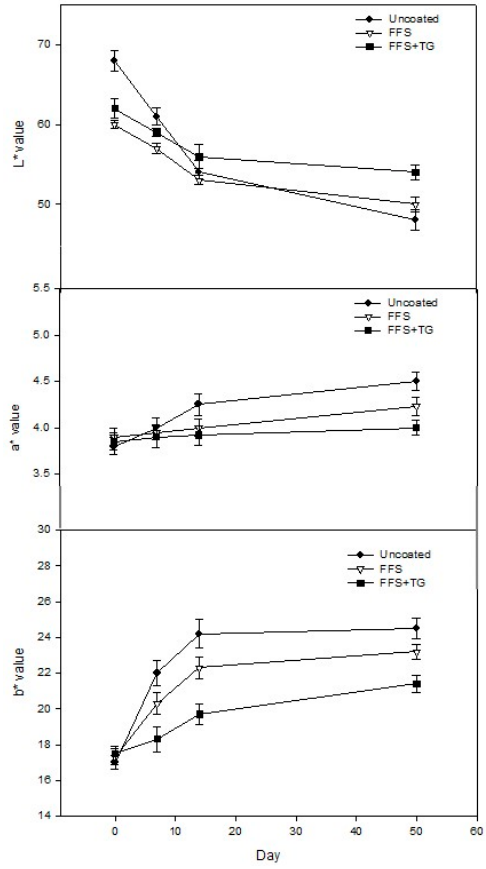
Figure 3. Color measurement of peanut surfaces for uncoated and coated peanuts with FFS or FFS+TG during 50 days of storage. N = 30, values are mean ± standard deviation.